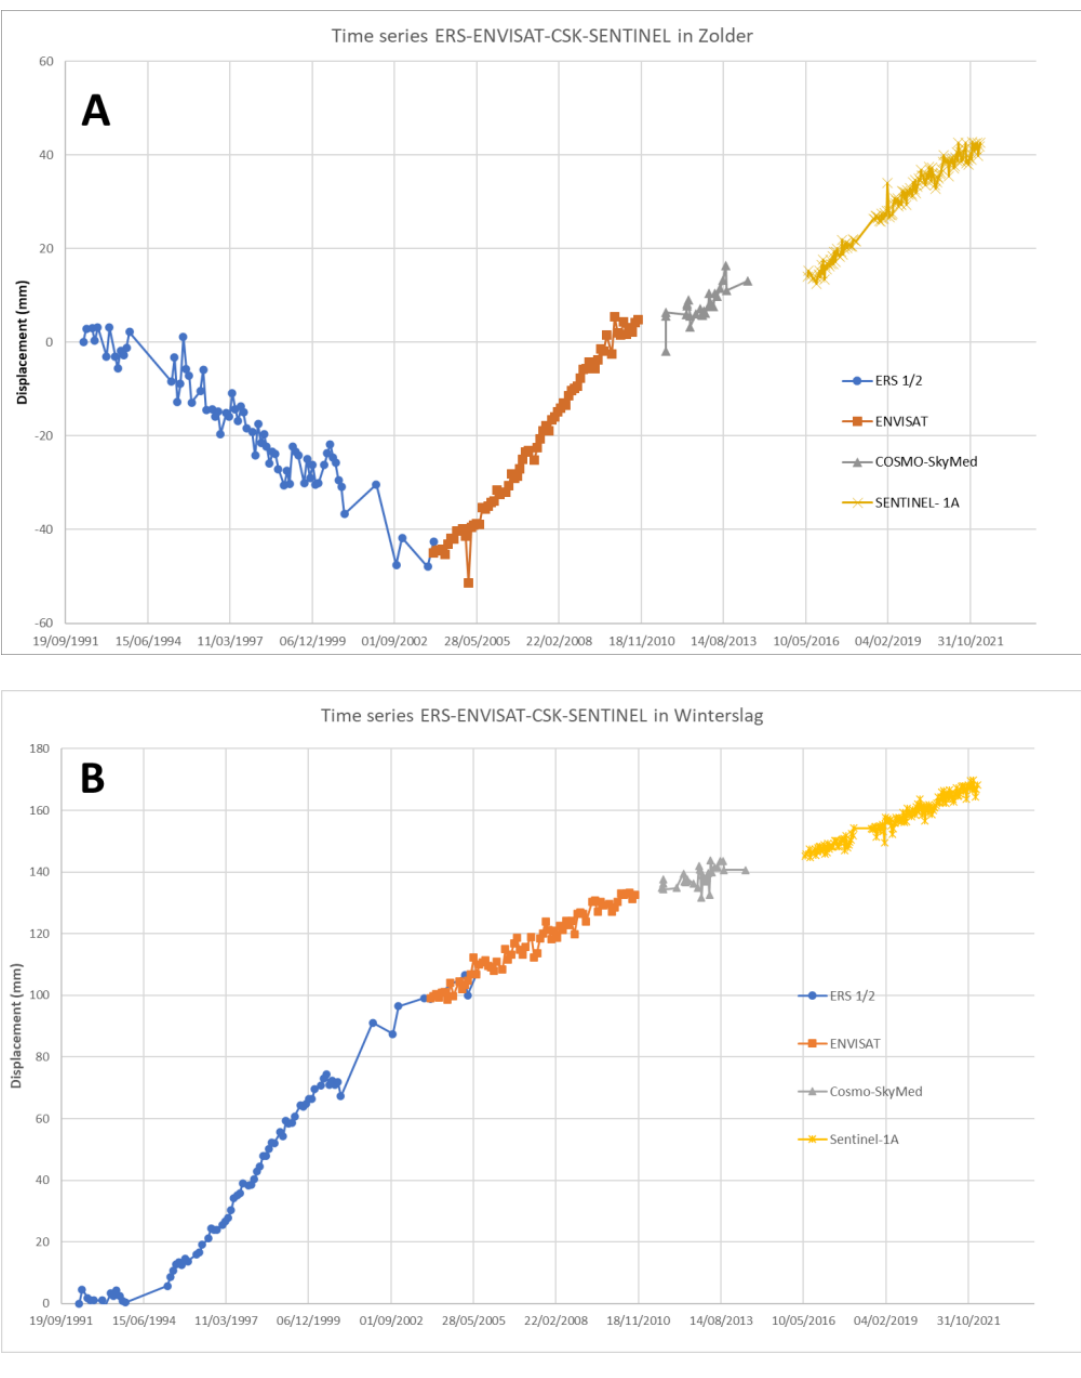
Figure 8. ( A ) Time-series displacement of LOS values of PS points in the vicinity of the Zolder coal concession, showing the vertical displacement (in mm) for the data from the four SAR satellites. ( B ) Time-series displacement of LOS values of PS points in the vicinity of the Winterslag coal conces- sion, showing the vertical displacement (in mm) for the data from the four SAR satellites.